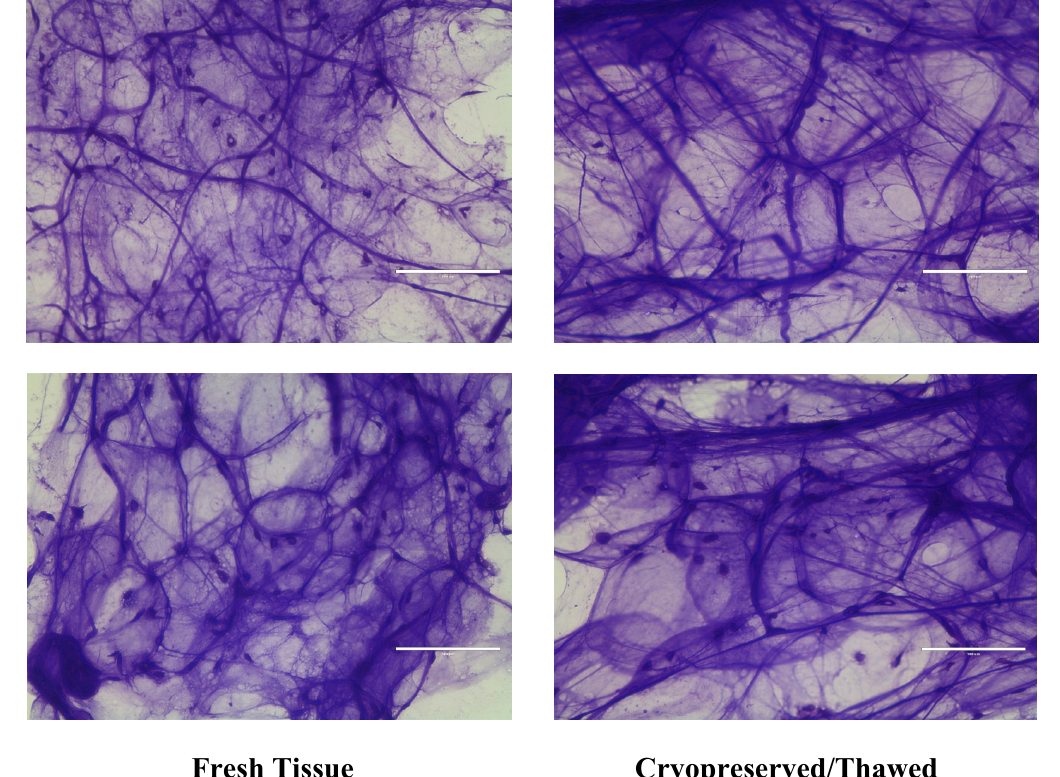
Figure 4. No gross differences between fresh and frozen histology. Adipose tissue was mounted on slides and then stained with crystal violet. No differences in structure are observed in fresh or cryopreserved/thawed tissue.